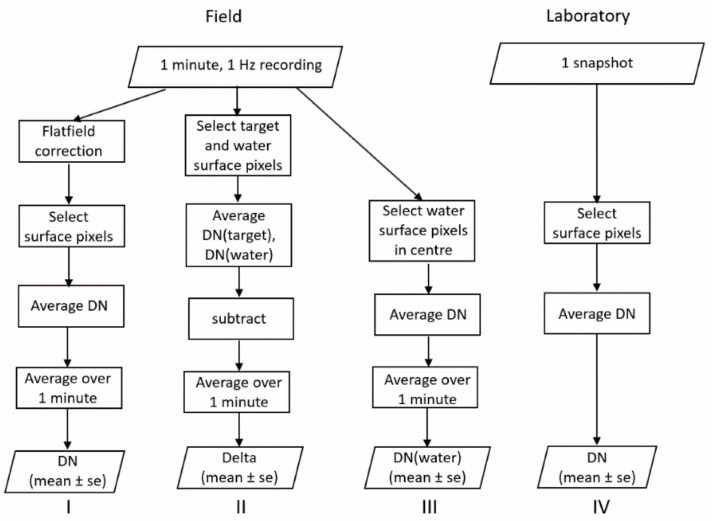
Figure 1. Diagram showing the image-processing workflows for FLIR field measurements (I–III) and laboratory measurements (IV). Processing workflows I–III before the 1-min average applies to individual images; se is standard error of the mean. Surface pixels in I and IV can be of the water or the